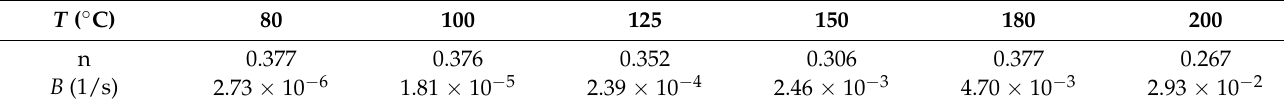
Table 4. Aging temperatures, the corresponding time exponents and rate constants (Ø0.71 wire, 80–200 ◦